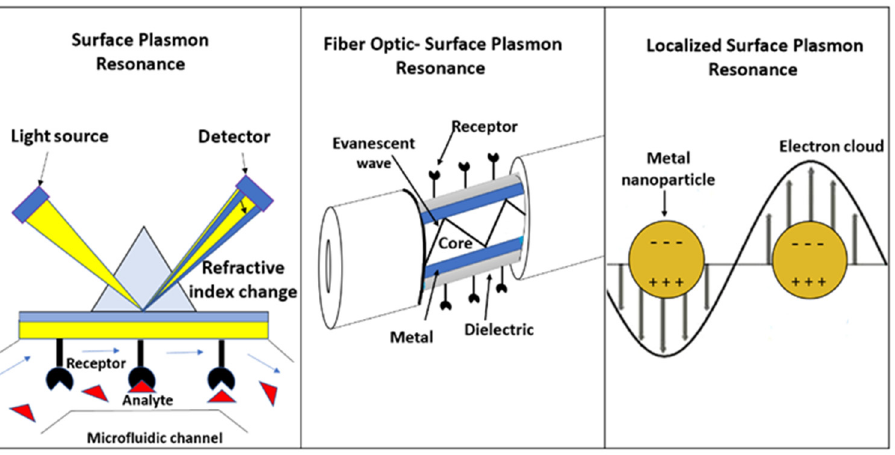
Figure 2. Schematic representation of prism-based surface plasmon resonance, fibre-optic SPR, and localised SPR.